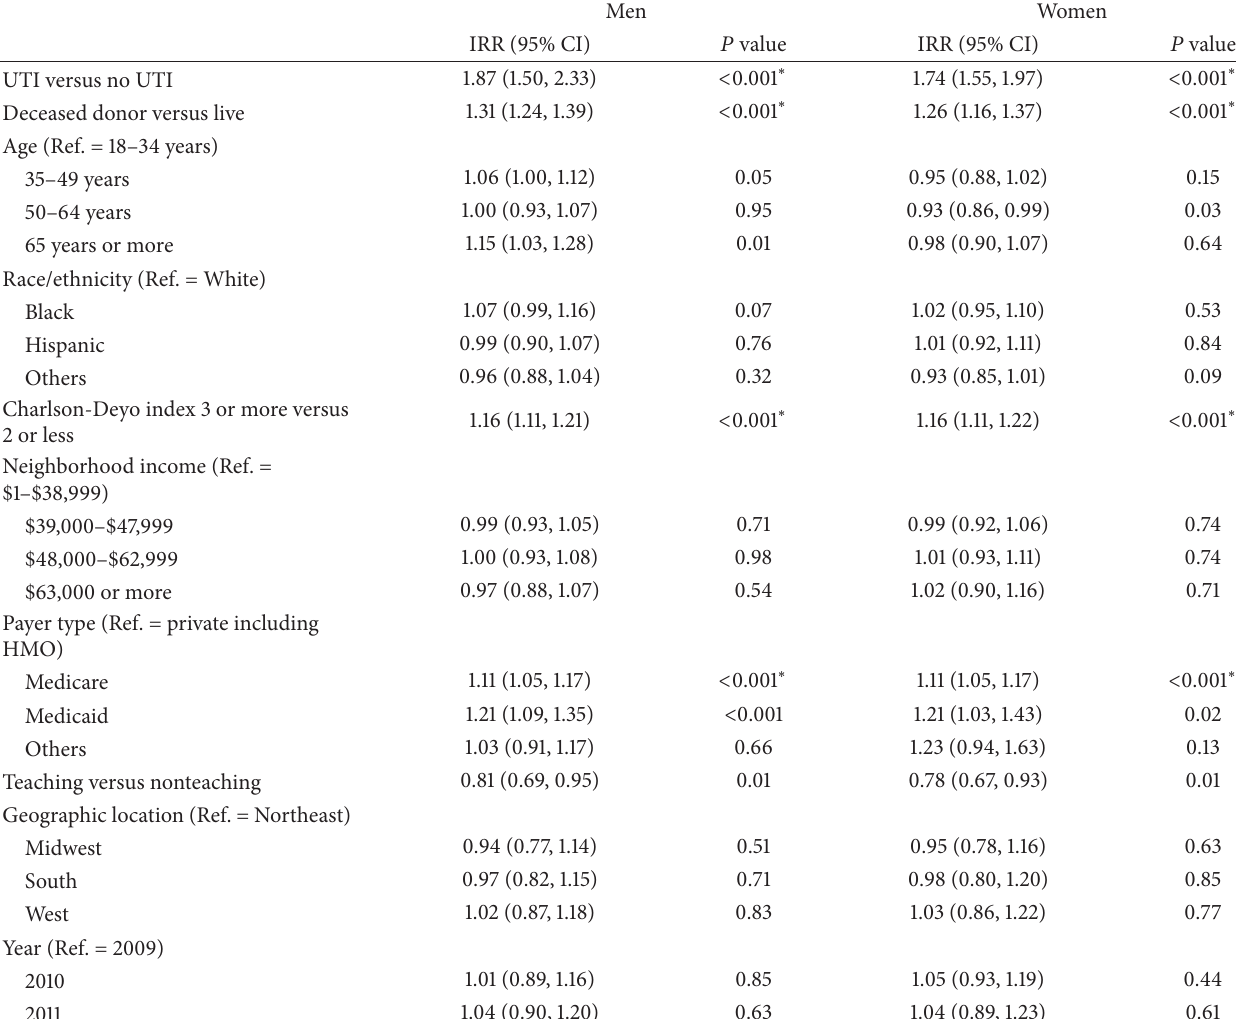
Table 4: Multivariable negative binomial incidence rate ratio (and 95% CI) for length of stay among renal transplant recipients, NIS 2009– 2011.